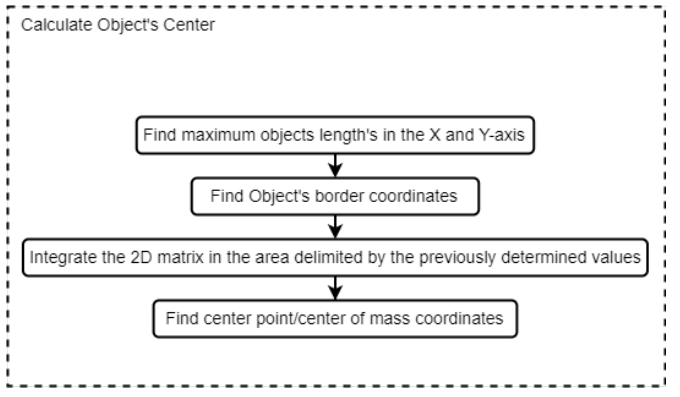
Figure 11. Center-point algorithm.